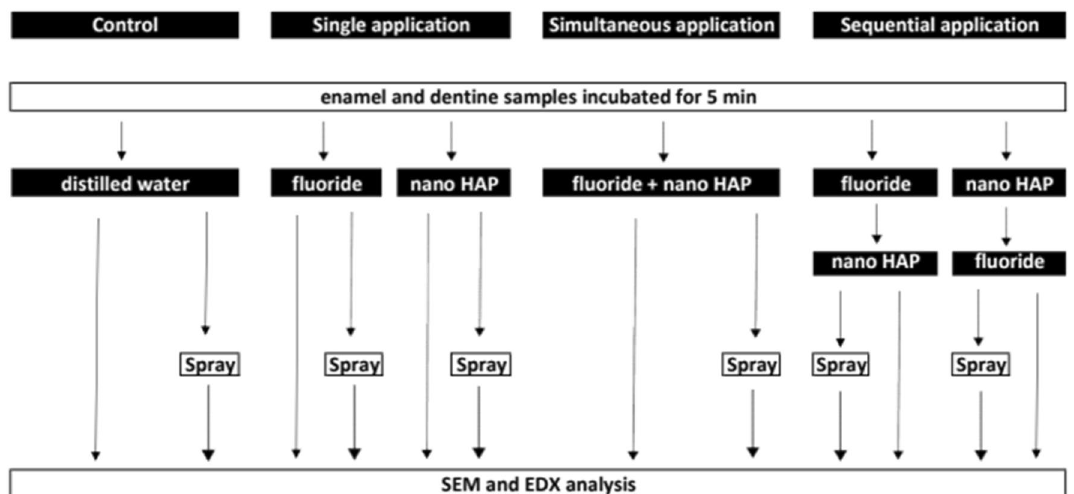
Figure 1. Flow chart of the application protocols fluoride = sodium fluoride, olaflur or elmex Fluid. Nano- HAP hydroxyapatite